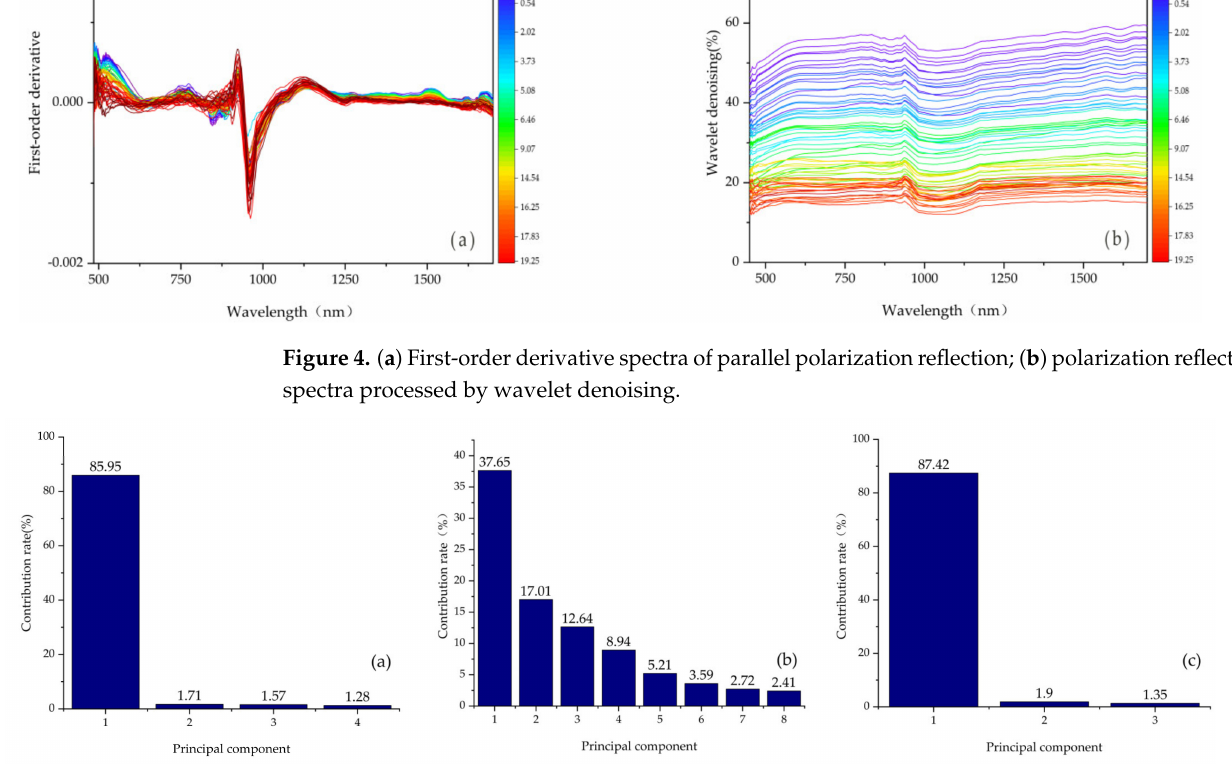
Figure 5. ( a ) PCA of the parallel polarization spectrum, ( b ) PCA of first-order derivative spectrum and ( c ) PCA of wavelet denoising